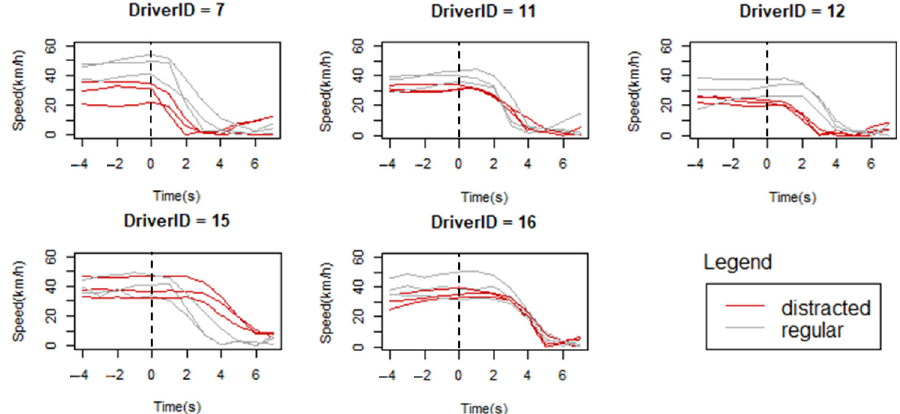
Figure 5 Examples of vehicle speed pro fi les for each